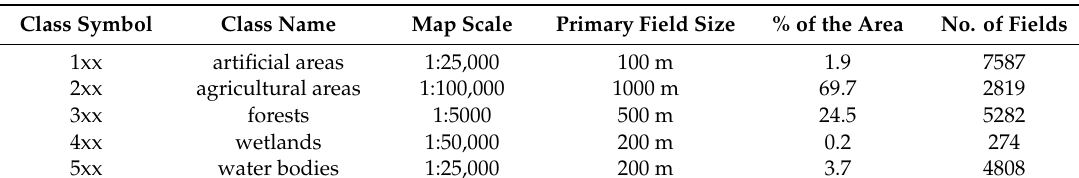
Figure 4. Fragment of map created using di ff erent field sizes ( A ) and its comparison with a map in the scale of 1:100,000 ( B ). Table 2. Corine Land Cover classes.